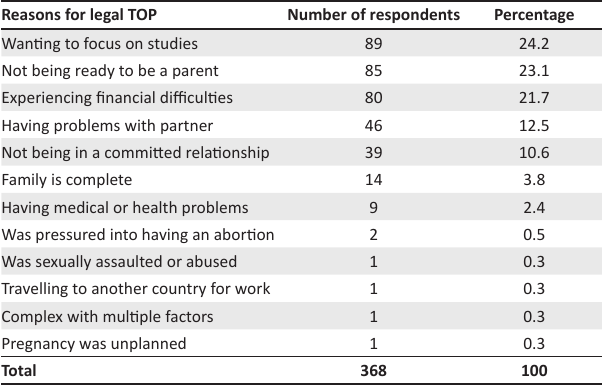
TABLE 2: Reasons for seeking legal termination of pregnancy. Reasons for legal TOP Number of respondents Percentage